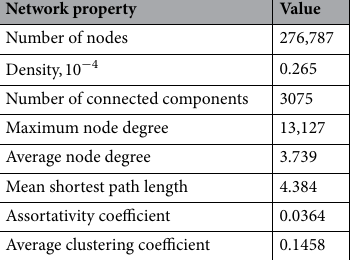
Table 2. Social network properties of the full Twitter data